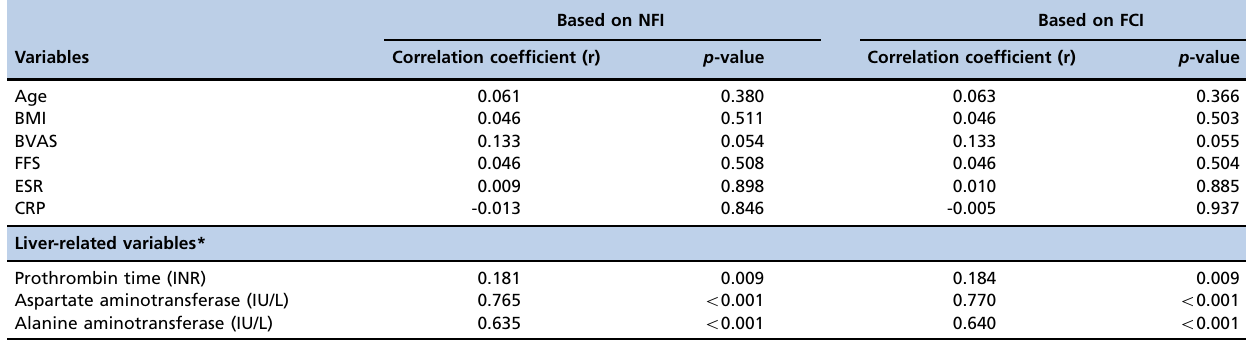
Table 2 - Correlation of continuous variables with either NFI or FCI at diagnosis in AAV patients.